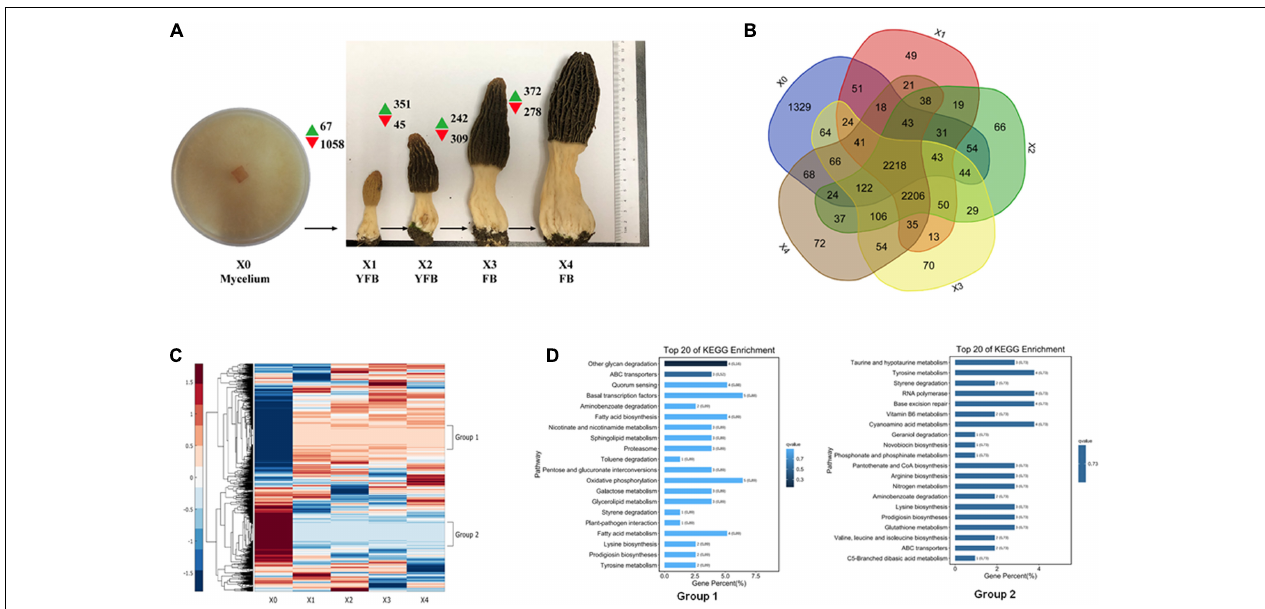
FIGURE 3 | Expression analysis of developmental stages of Morchella conica SH. (A) Gene expression map of five developmental stages. Green and red arrows denote the numbers of significantly up- and downregulated genes [ p < 0.05, fold change (FC) > 4], respectively. The development of X0 (mycelium), X1–X2 young fruiting body (YFB), and X3–X4 fruiting body (FB) is shown. Each sample was sequenced in three biological replicates. (B) Venn plot shows the number of detected genes overlapping in the compared developmental stages. (C) Heatmap shows the differentially expressed genes (DEGs) during the five development stages of M. conica SH; group 1 and group 2 represent distinct expression patterns. (D) . Kyoto Encyclopedia of Genes and Genomes (KEGG) enrichment of genes in group 1 and group